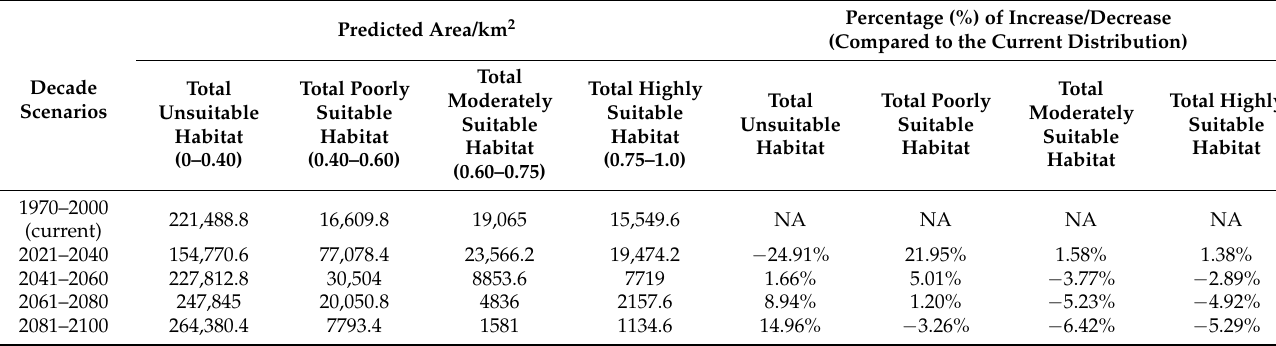
Table 6. Predicted suitable areas for AlfWB disease (16SrII-D) under current and future climatic conditions.